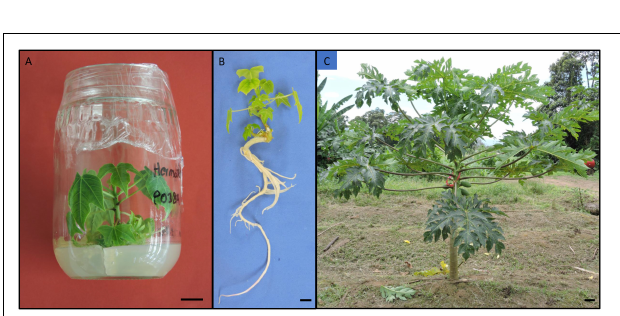
FIGURE 6 | In vitro papaya plant ready for ex vitro acclimatization with 3–5 cm long (A) , a well-developed root system (B) and a field established plant with fruits and flowers (C) after 6 months of culture in Guapiles, Costa Rica, a humid tropical zone. Bars equivalent to 1 cm (A,B) and 10 cm (C)